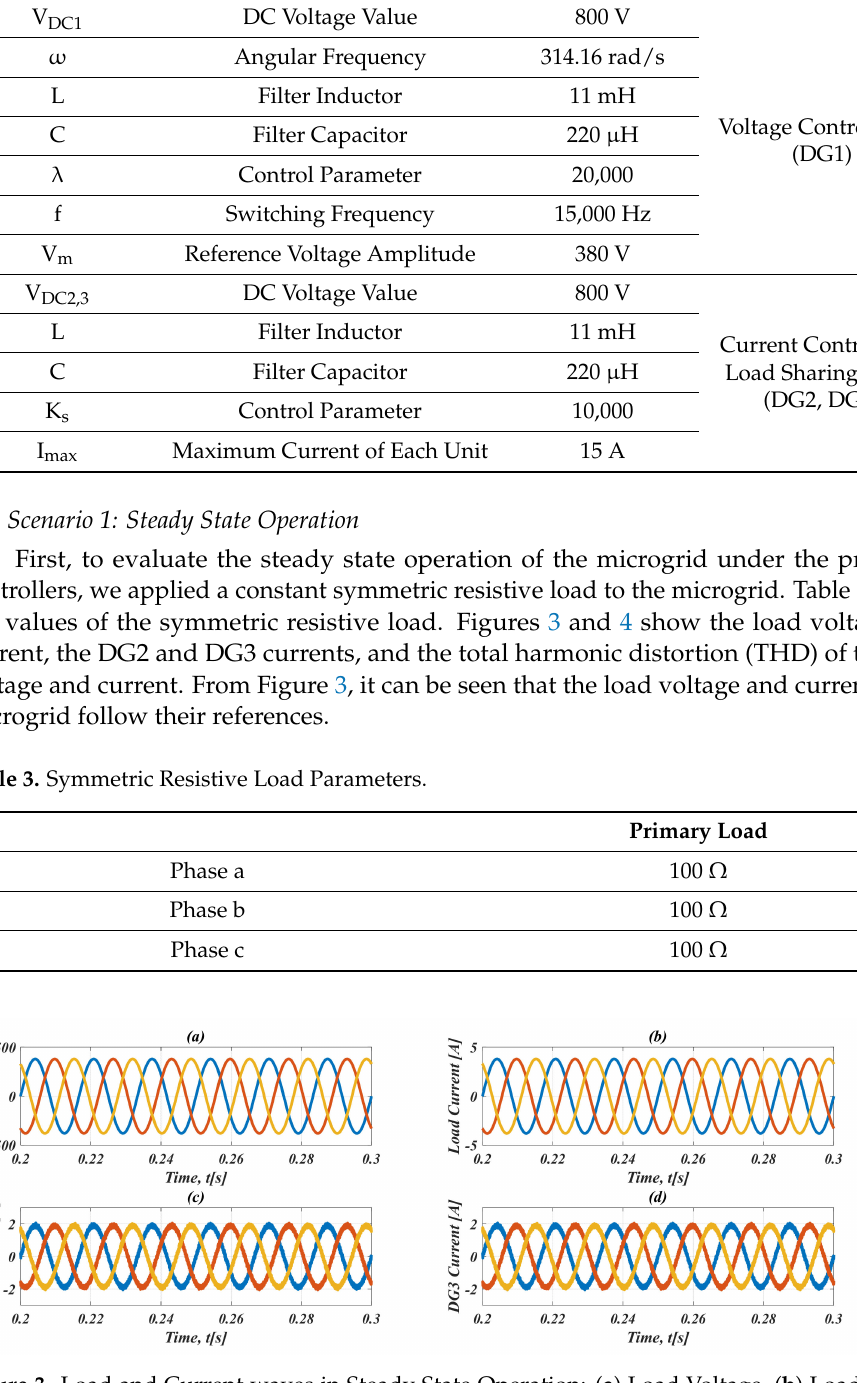
Figure 3. Load and Current waves in Steady State Operation: ( a ) Load Voltage, ( b ) Load current, ( c ) DG2 Current, ( d ) DG3